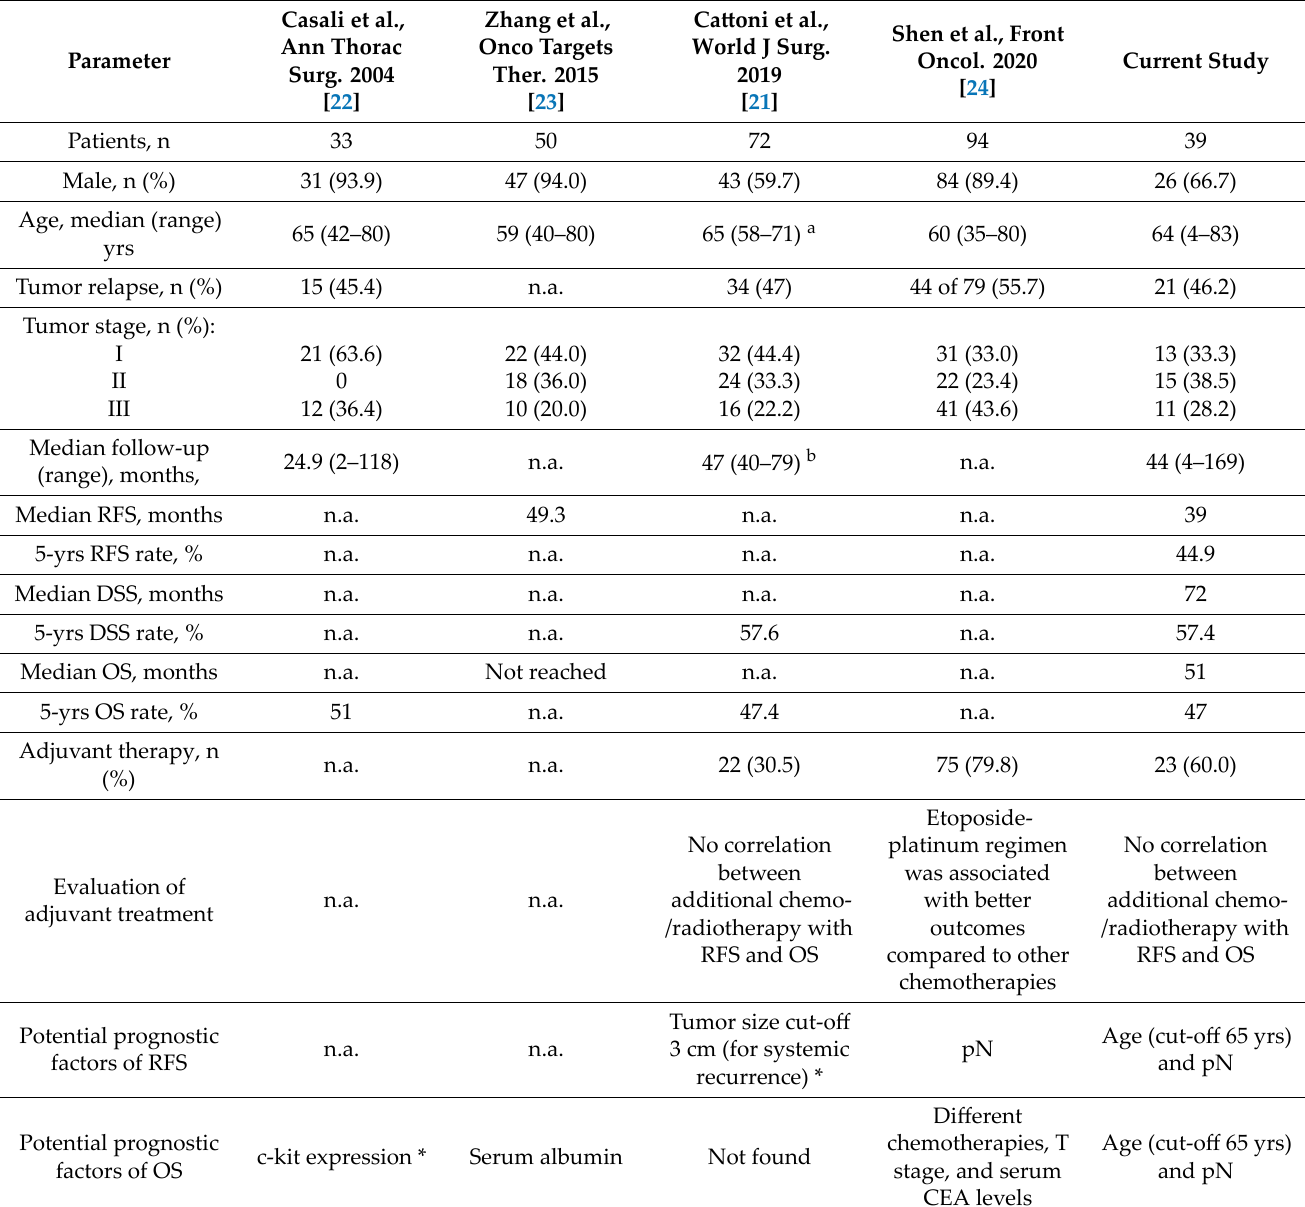
Table 1. Review of the literature on clinical outcomes in early and locally advanced pure LCNEC after complete tumor resection compared to our